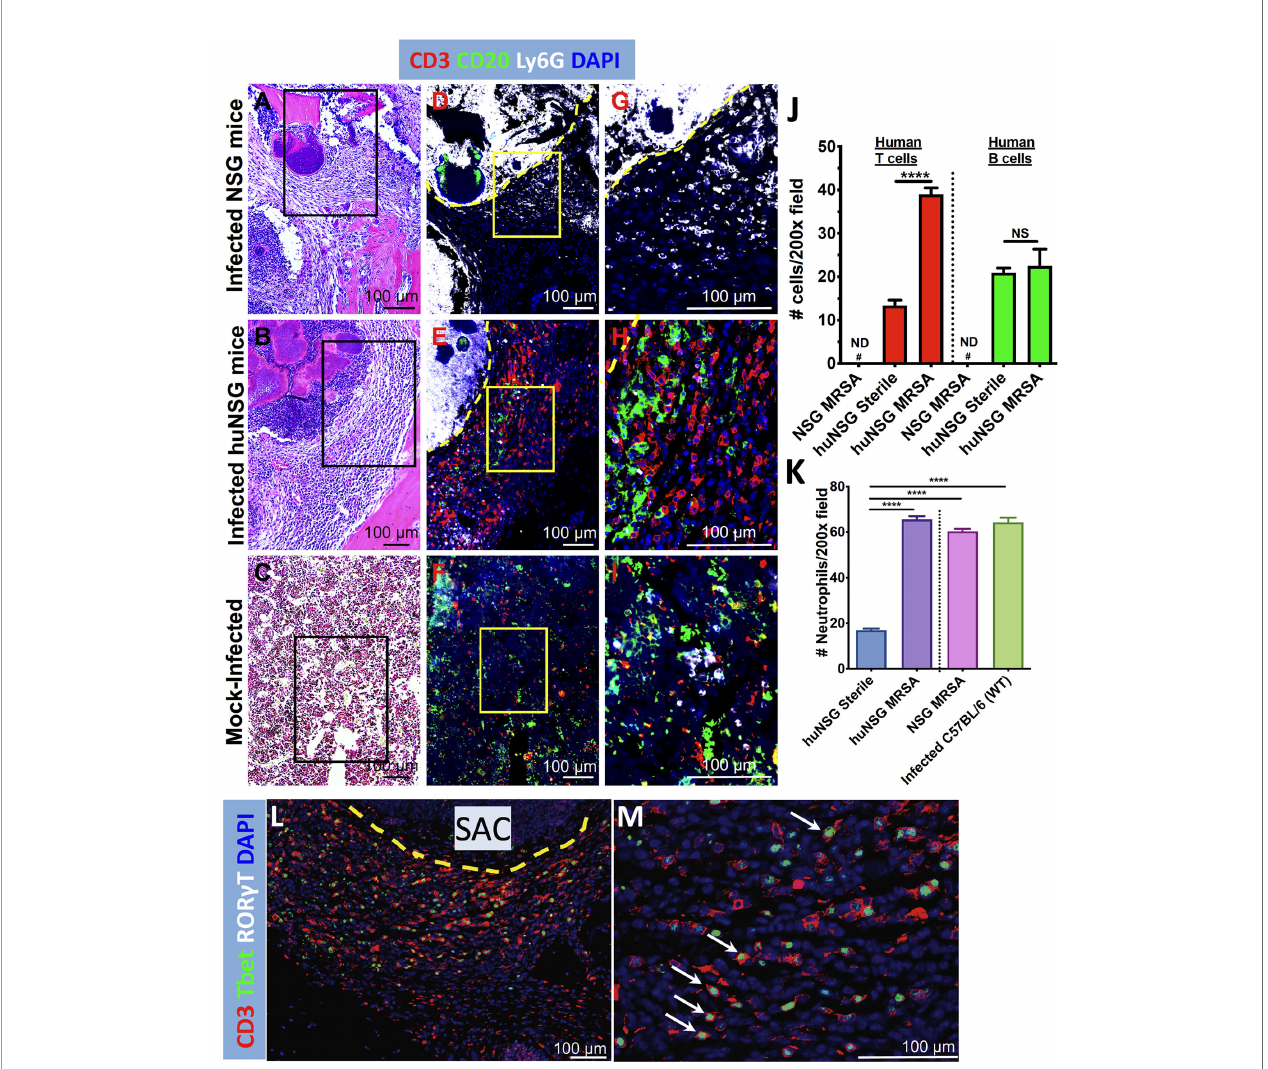
anti-human ROR g T. Light microscopy of the H&E stained sections (A – C) , and fl uorescent microscopy of adjacent 5 m m sections (D – I) were performed on the SACs in tibiae from infected NSG, infected huNSG mice, and sham-control huNSG mice. Black squares in H&E images show the area depicted in 3x3 mosaic immuno fl uorescent micrograph. Yellow squares show higher magni fi cation images of the CD3 + T cells (red), CD20 + B cells (green), and Ly6G + neutrophils (white), in the sections of the 3x3 mosaic immuno fl uorescent micrographs. The dotted yellow line separates the SAC border from the rest of the bone marrow. Note that mouse Ly6G +